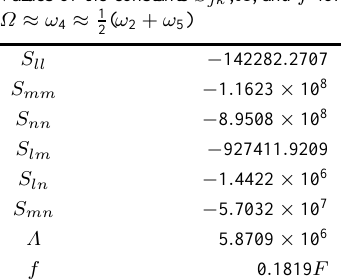
Values of the constants S jk , (cid:3) , and f for (cid:10) (cid:25) ! 4 (cid:25)